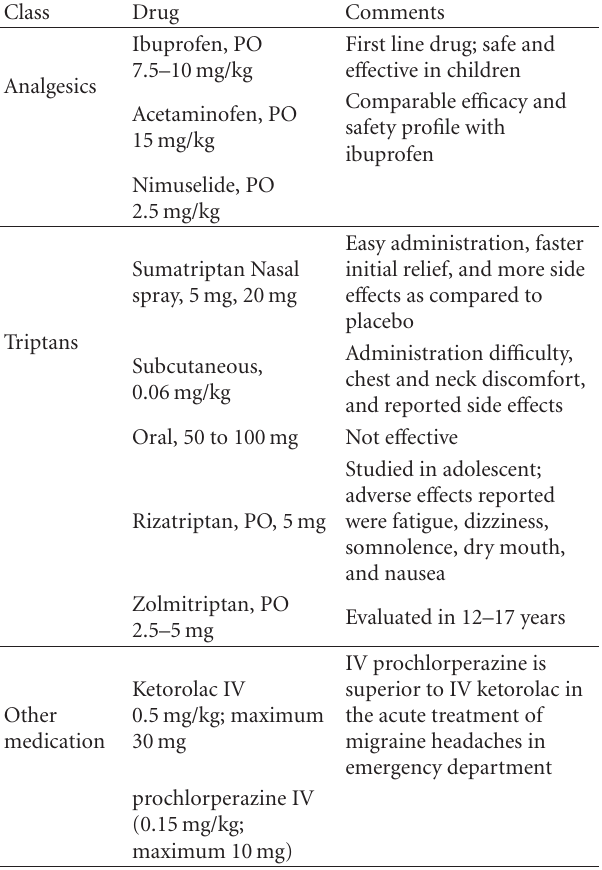
Table 5: Treatment of acute attacks of